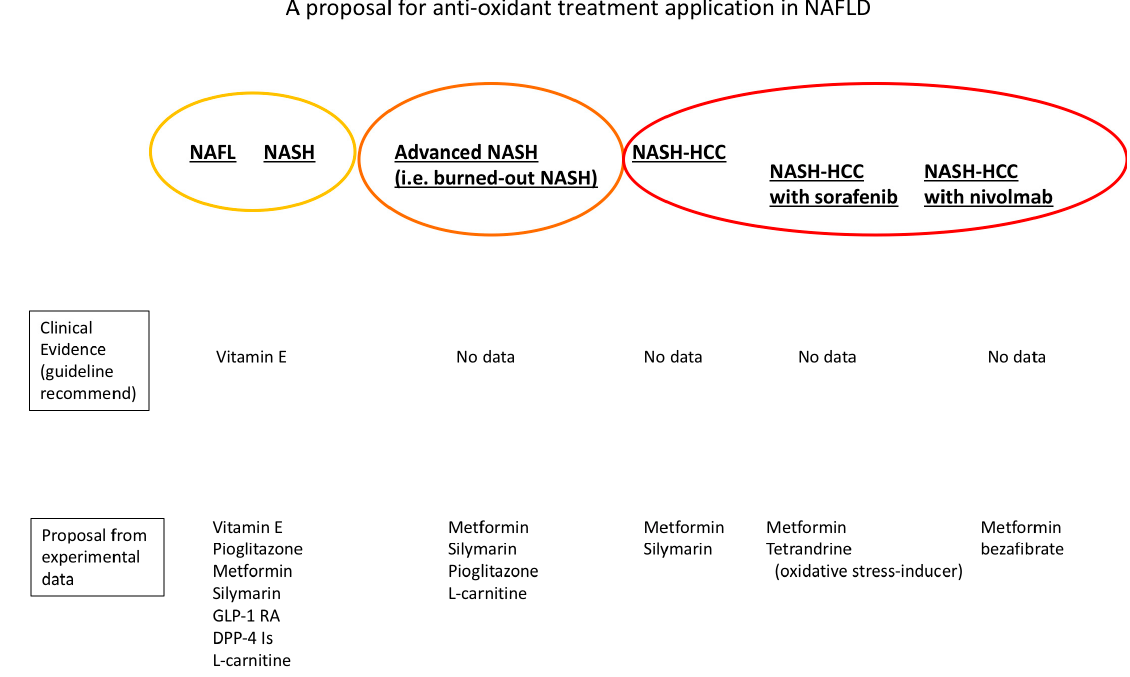
Figure 2. A proposal for the antioxidant treatment application in non-alcoholic fatty liver disease (NAFLD). NAFL, non-alcoholic fatty liver; NASH, Non-alcoholic steatohepatitis; HCC, hepatocellular carcinoma; GLP-1 RA, glucagon-like peptide 1-receptor agonist; DPP-4 Is, dipeptidyl-peptidase-4